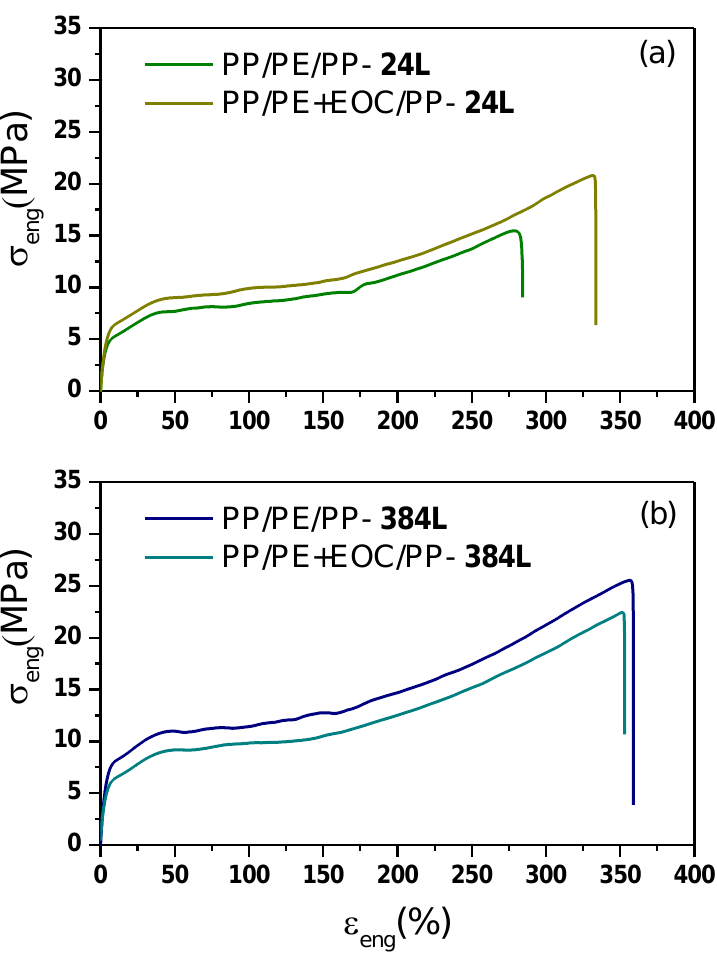
Figure 3. Engineering stress-strain plot of the PP/LLDPE/PP and PP/LLDPE + EOC/PP multilayer films (MD). Influence of the EOC compatibilizer on the films with: ( a ) 24 layers and ( b ) 384 layers. In the case of the nanolayered films with 384 layers, the effect of the EOC on the elonga- tion at break was almost unnoticeable, compared with the microlayered PP/LLDPE/PP-24L and PP/LLDPE + EOC/PP-24L films. However, a decrease of the tensile strength at yield and break was observed, due to the elastic nature of the EOC. Additionally, we observed that the compatibilized PP/LLDPE + EOC/PP-24L showed similar tensile properties to the PP/LLDPE/PP-384L system without compatibilizer (Table